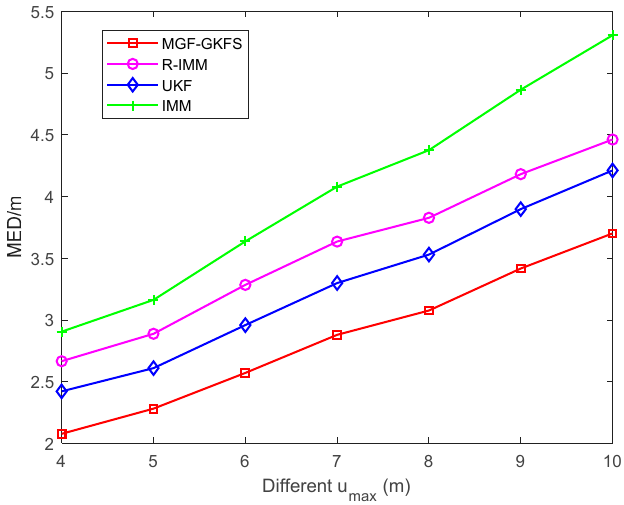
u of uniform distribution. Figure 10. The MED versus u max max of uniform